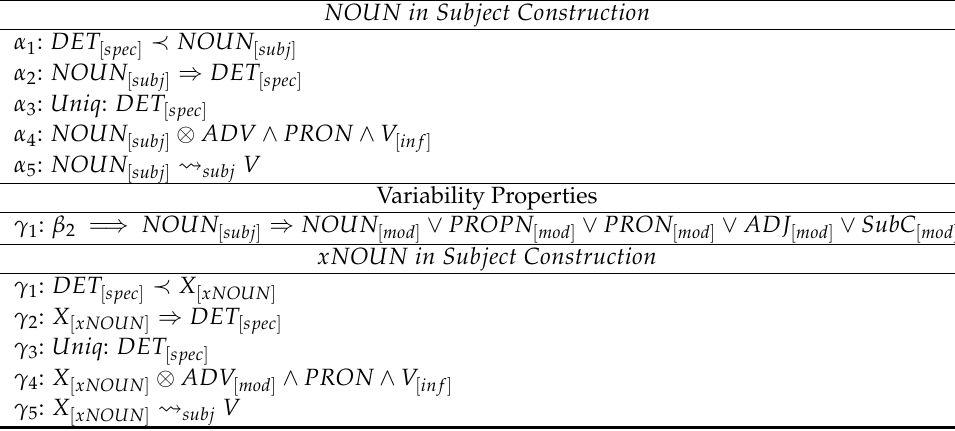
Table A1. Spanish properties of NOUN in subject construction.